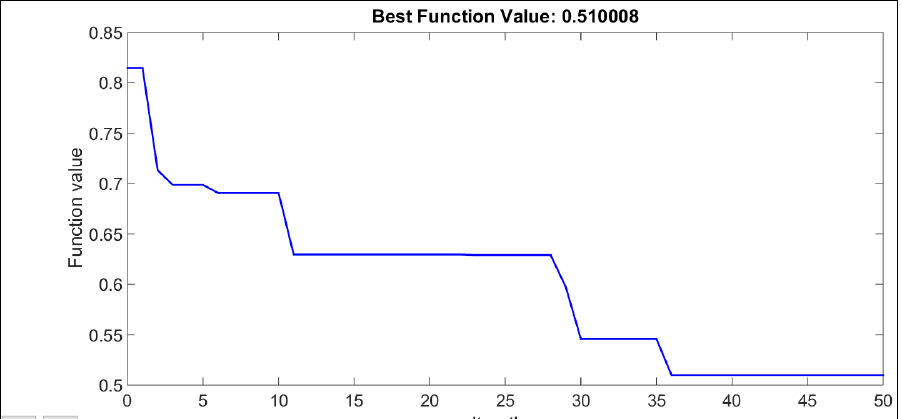
Figure 19. Fitness function of PSO algorithm to tune FLC